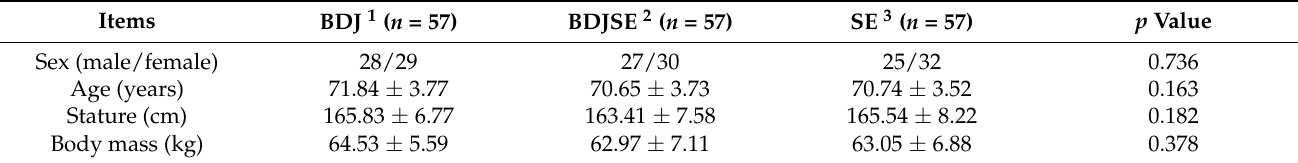
Table 1. Baseline demographic characteristics of the